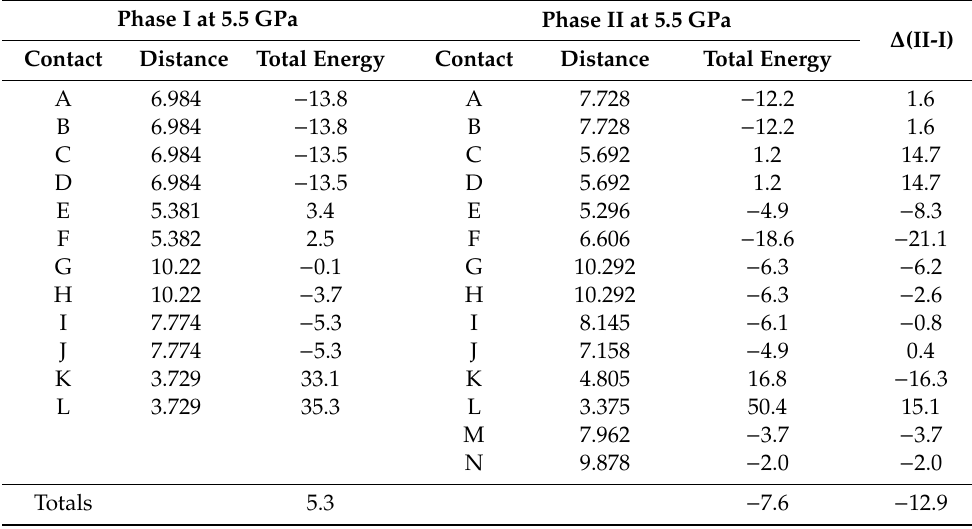
Table 4. Comparison of energies within the first coordination spheres in phases I and II at 5.5 GPa. Energies are in kJ mol − 1 and distances are in Å. Both structures were optimised by periodic DFT and the energies calculated using